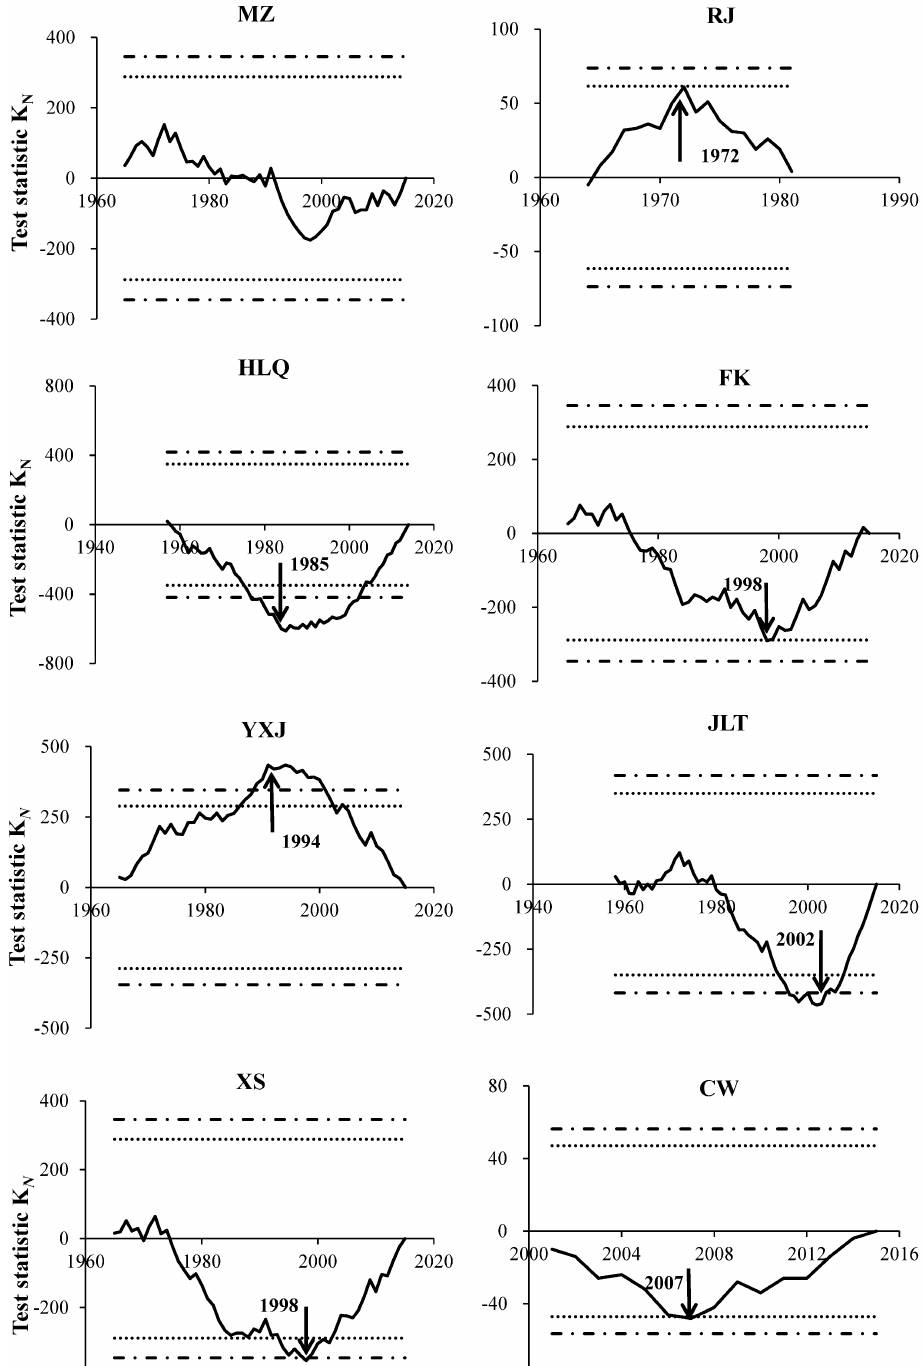
dashed lines are the mean values and trend lines, respectively, and the vertical dashed lines indicate the transition years.